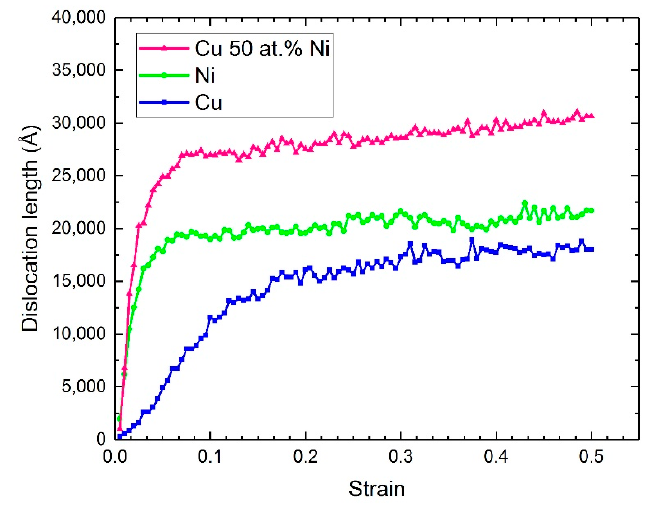
Figure 5. Shockley dislocation length as a function of strain.